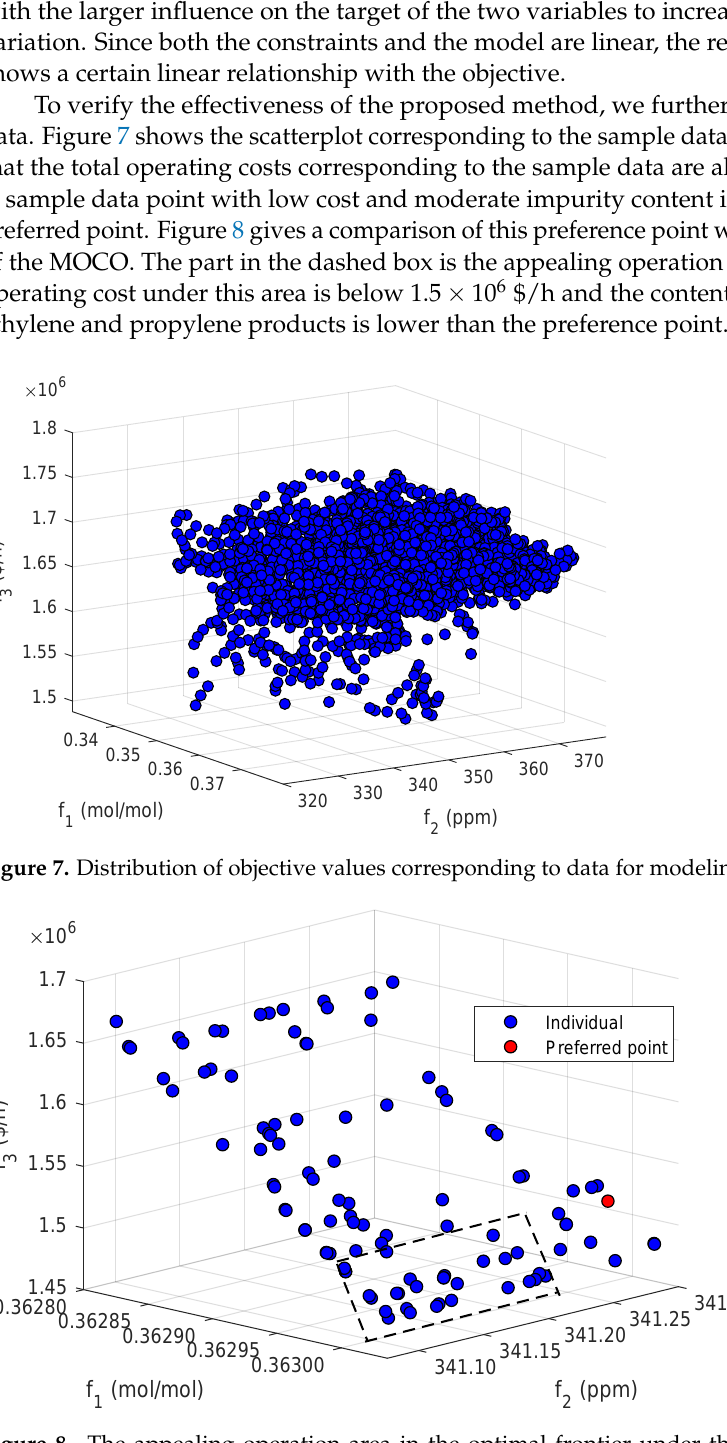
Figure 8. The appealing operation area in the optimal frontier under the guidance of a prefer- ence